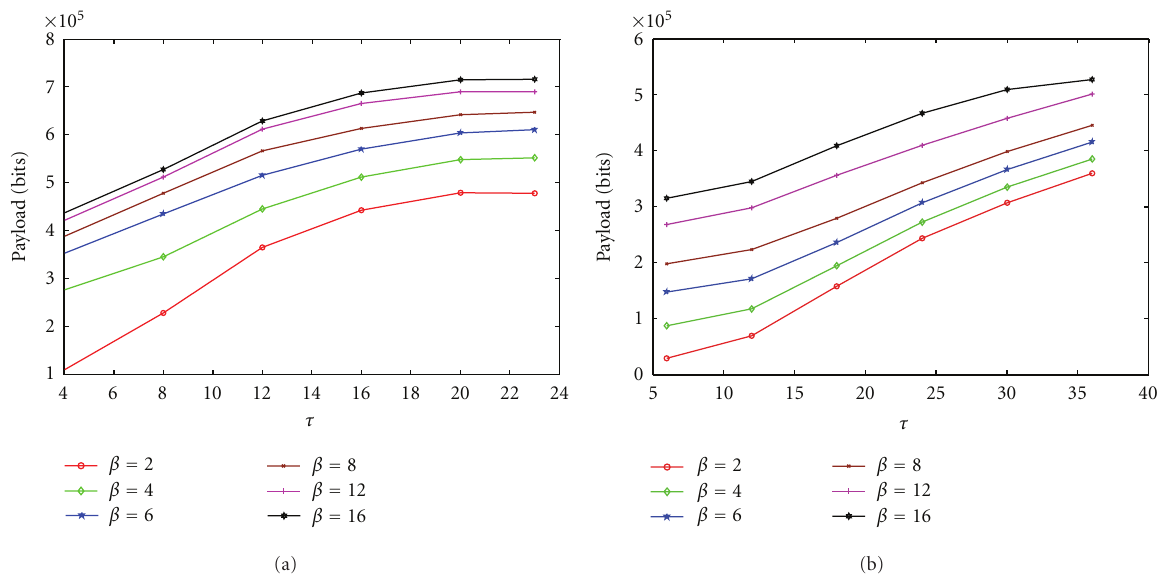
Figure 6: Relationship between the payload and the control parameters β (with γ − 1) and τ for the proposed method on the test images. (a) Lena and (b) Baboon .